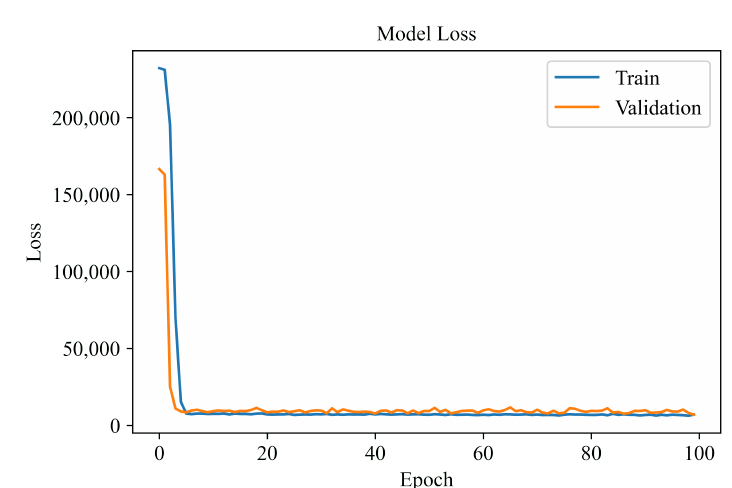
Figure 4. Loss for 63 days model.